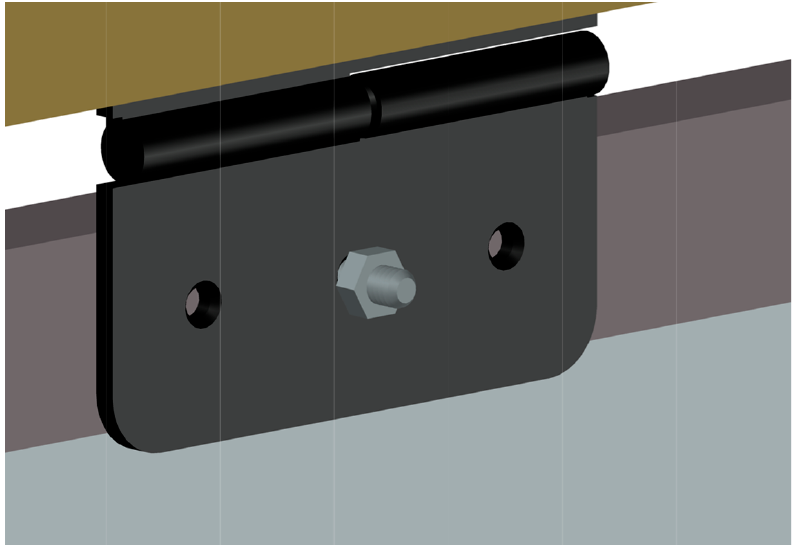
Figure 4. Module hole aligning with the middle bottom flange hinge hole, which is held by ¼ ″ × 1-1/2 ″ galvanized carriage bolts, where connections are secured with a nut and washer. The build is complete when all connections are secured as shown in Figure 5. For the end of life, or to move the system, it can then be disassembled in reverse order.